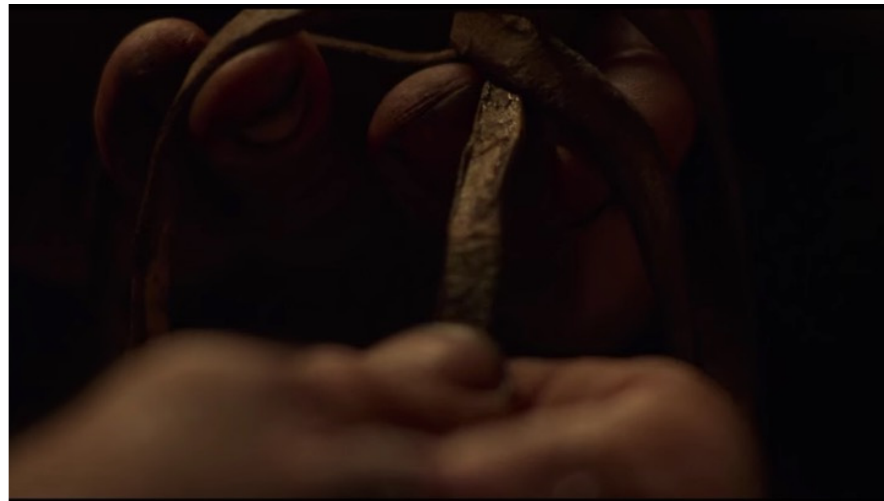
Figure 12. The Power of the Dog . Netflix.